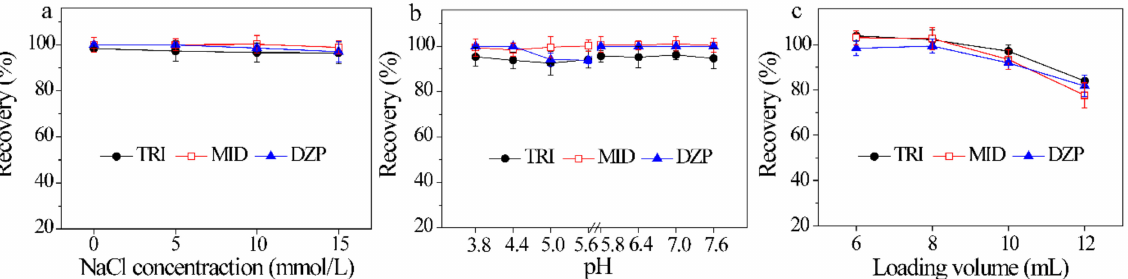
Figure 4. Effects of ( a–c ) ionic strength of sample solution, pH of sample solution and loading volume on the recoveries of three BZDs ( n =